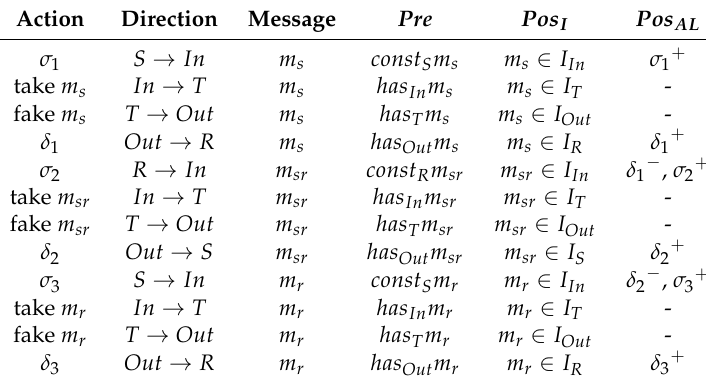
Table 3. Action model including intruder’s